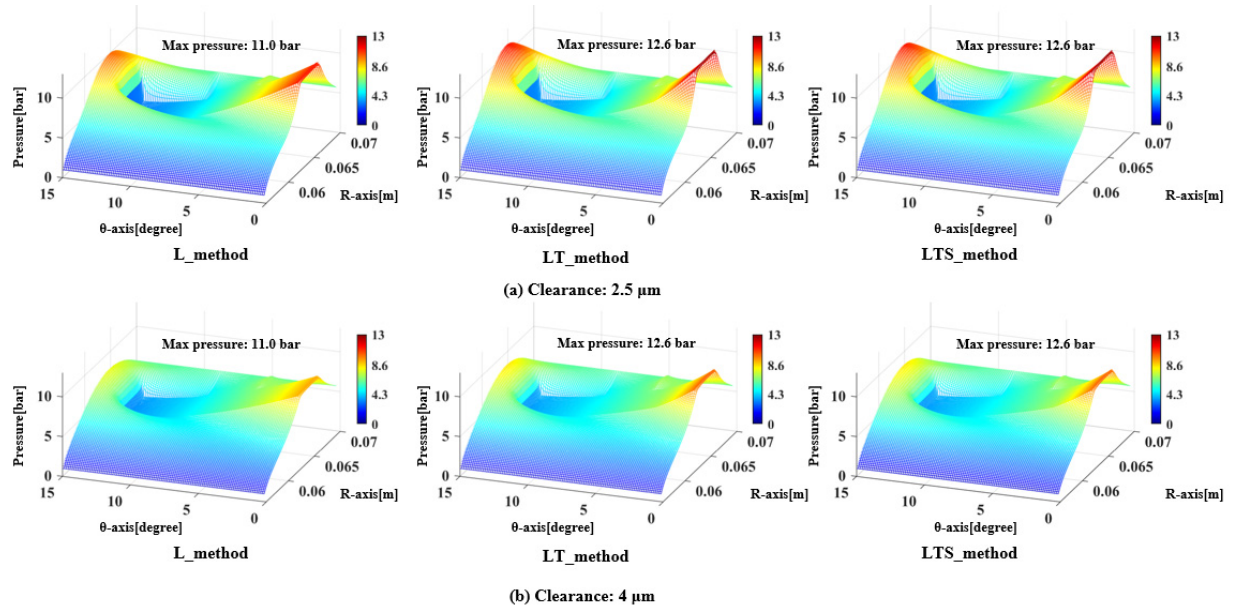
Figure 9. Pressure due to the laminar, turbulent, and slip conditions of the fluid film at an outer pressure of 6 bar.